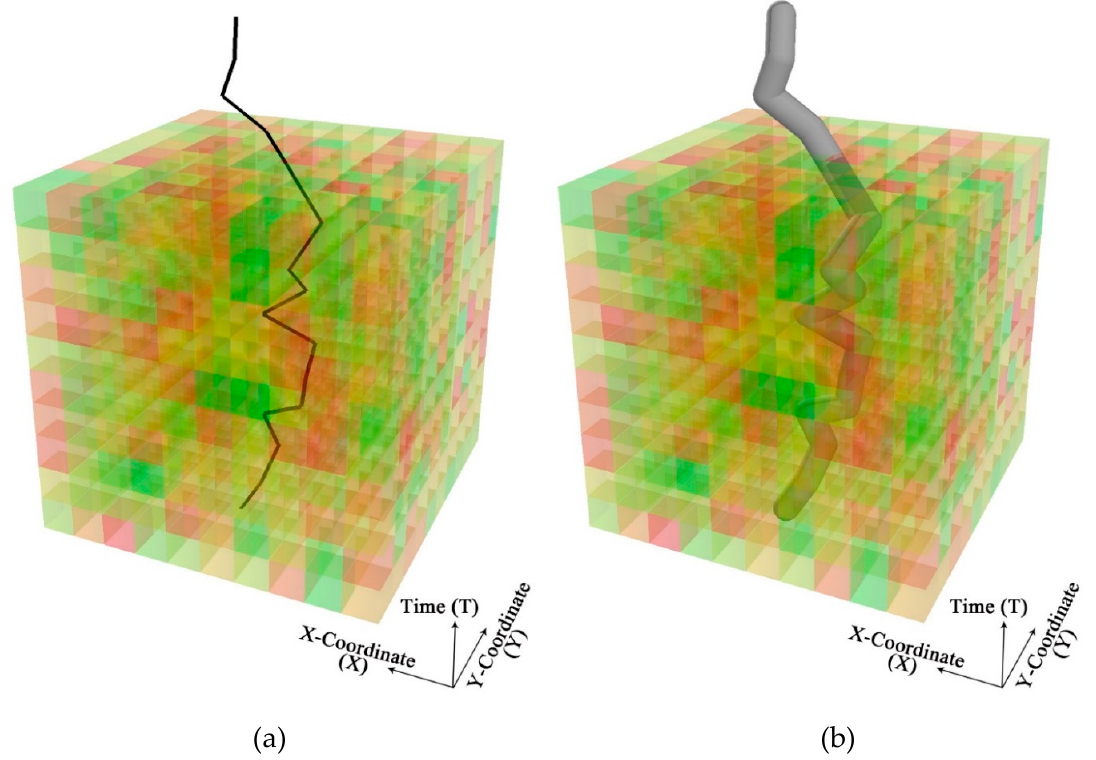
Figure 6. A GPS trajectory ( a ) and an individual space-time tunnel ( b ) projected into an environmental context cube.